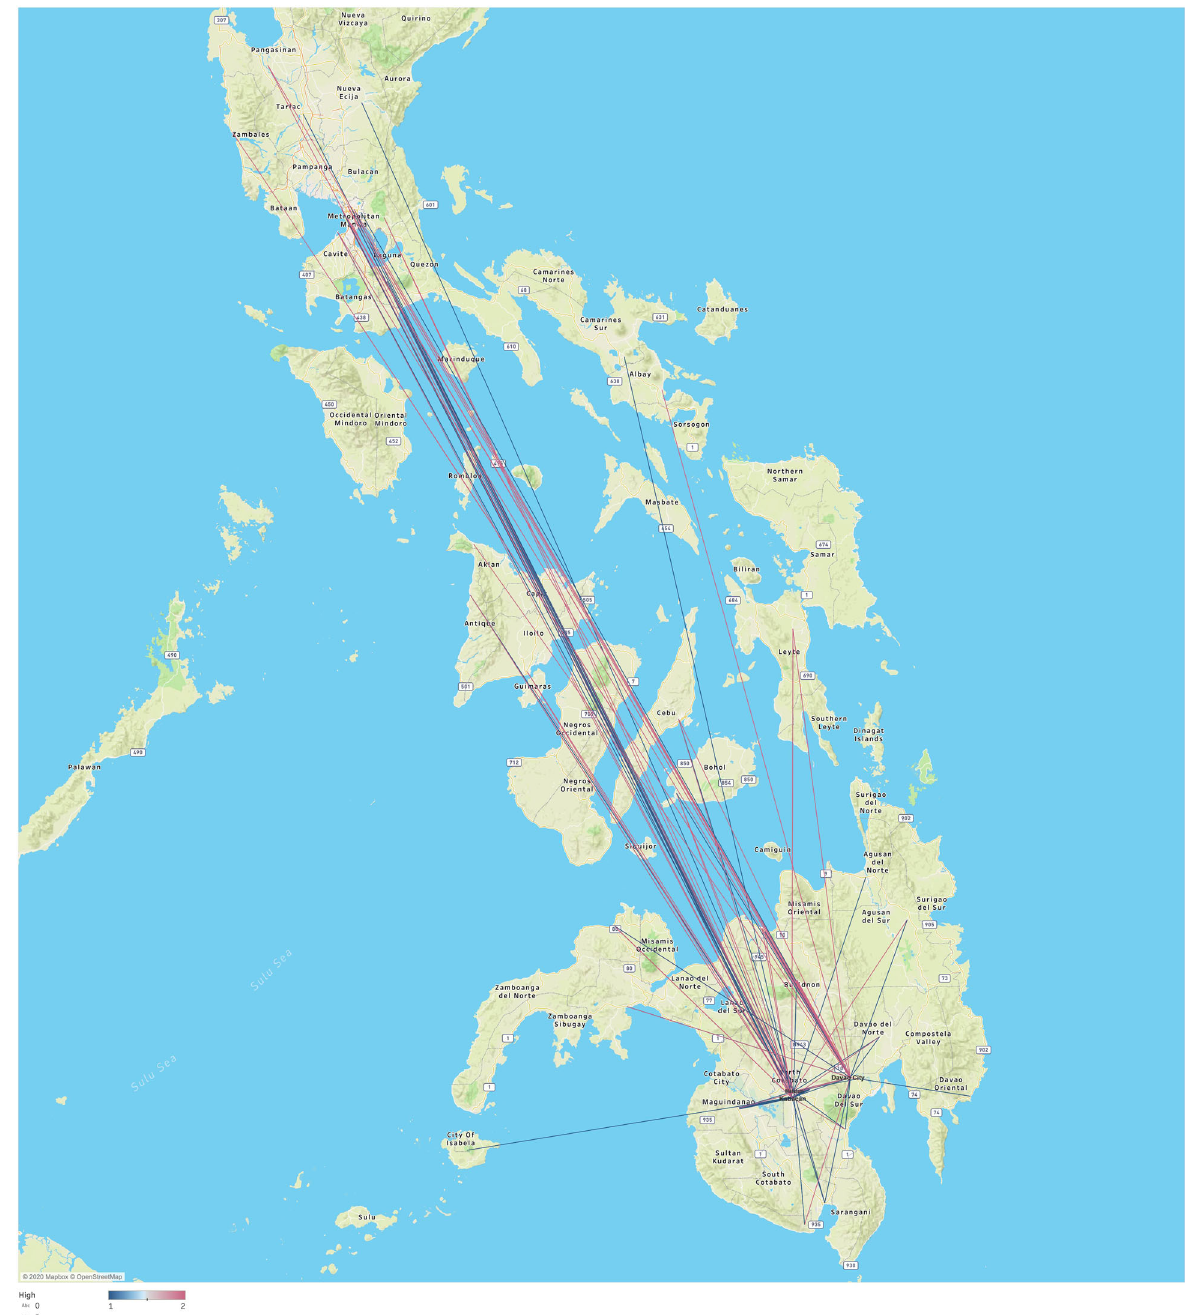
Fig. 3 Overview of internal migration movements from Mindanao. Internal migration fl ows generated from the study sites in Mindanao. The blue lines indicate male movements while the red lines show female